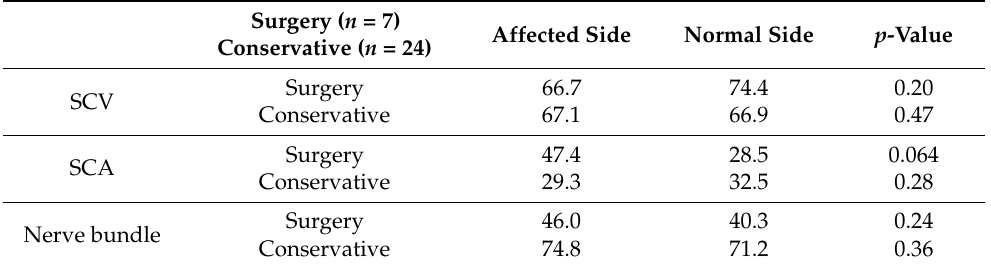
Table 4. Stricture rate of SCV, SCA, and nerve bundle on surgery and conservative group. There was a trend toward greater stenosis on the affected side of the SCA in the surgery group.